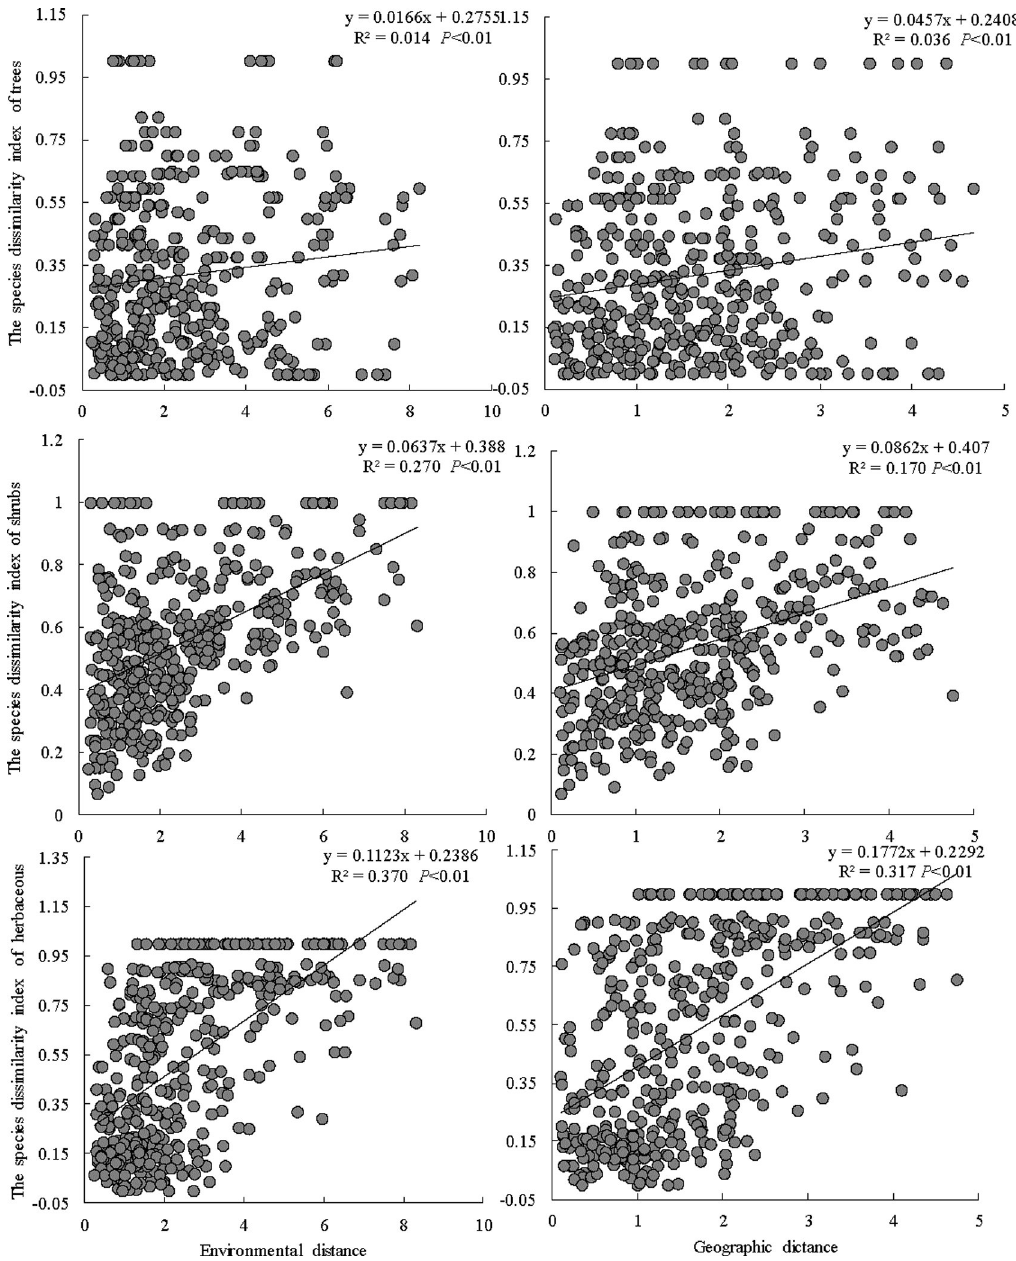
Fig 4. Relationships between the species diversity index and geographical distance and environmental